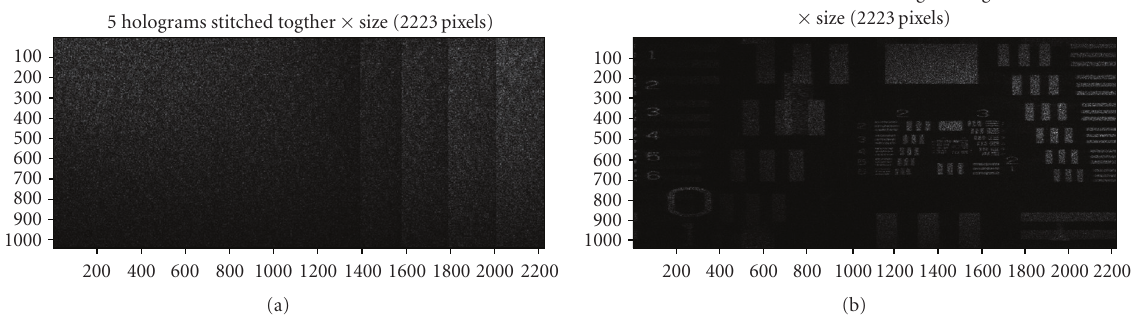
Figure 12: (a) Amplitude of a Synthetic Aperture digital hologram. Five recordings have been stitched together. The resultant hologram has clear discontinuities that would not be visible in the ideal case. Stitching has also been implemented in the spatial frequency domain. Approximately 300 pixels are added with each addition capture. The SA DH has 2223 pixels in the x direction. In (b) we show the reconstruction of SA